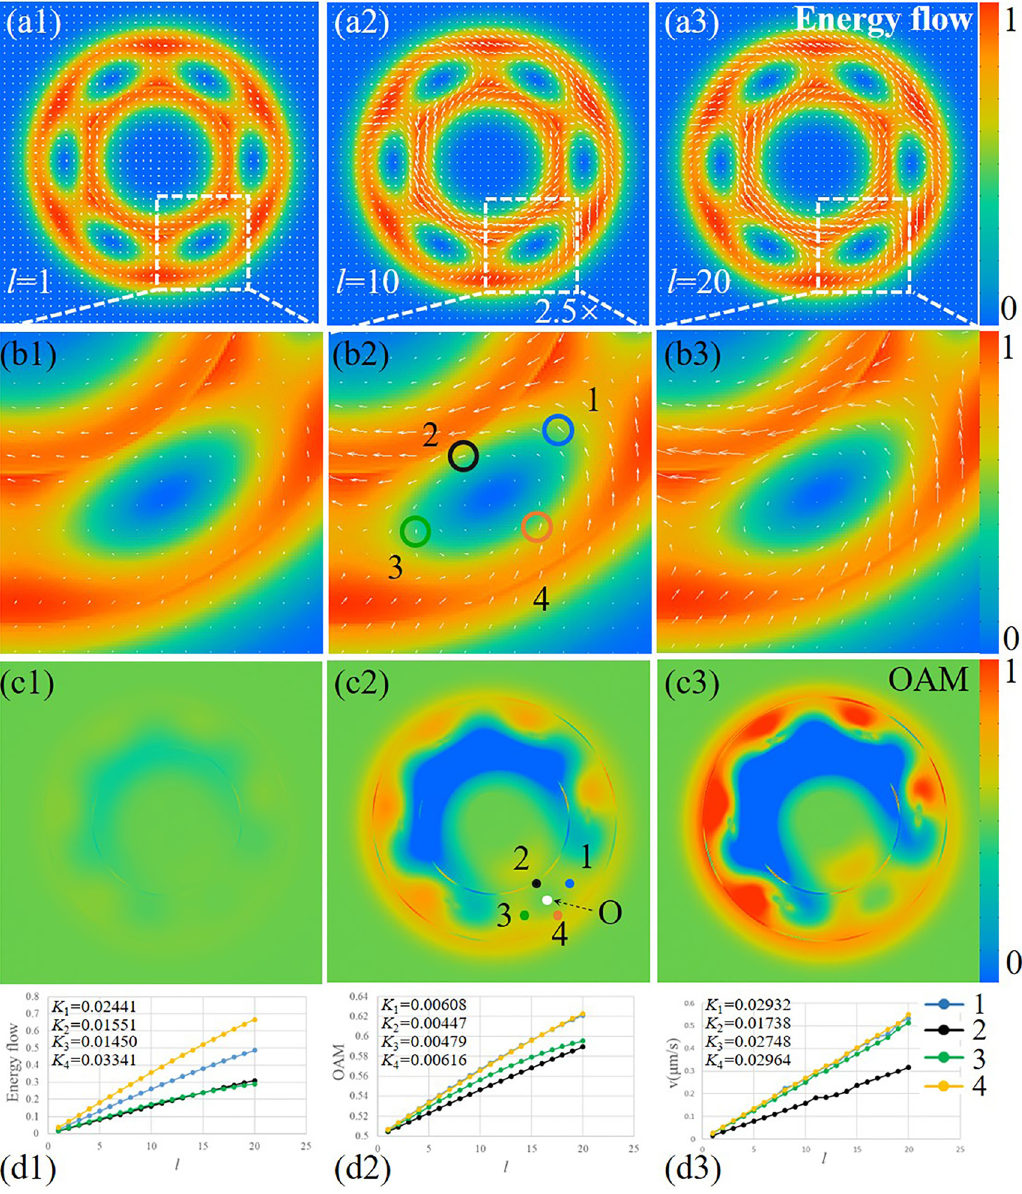
Figure 6: Change in the energy flow and OAM with increasing l . (a1) – (a3) Energy flows, (b1) – (b3) local magnification of OVs in the lattice, and (c1) – (c3) OAM density distributions. The axis of symmetry is located at the center of the specific OV, i.e., at point O. (d1), (d2), and (d3) Energy fl ows, OAM, and rotation speed at speci fi c points versus l , respectively. Note that energy fl ow and OAM are normalized,